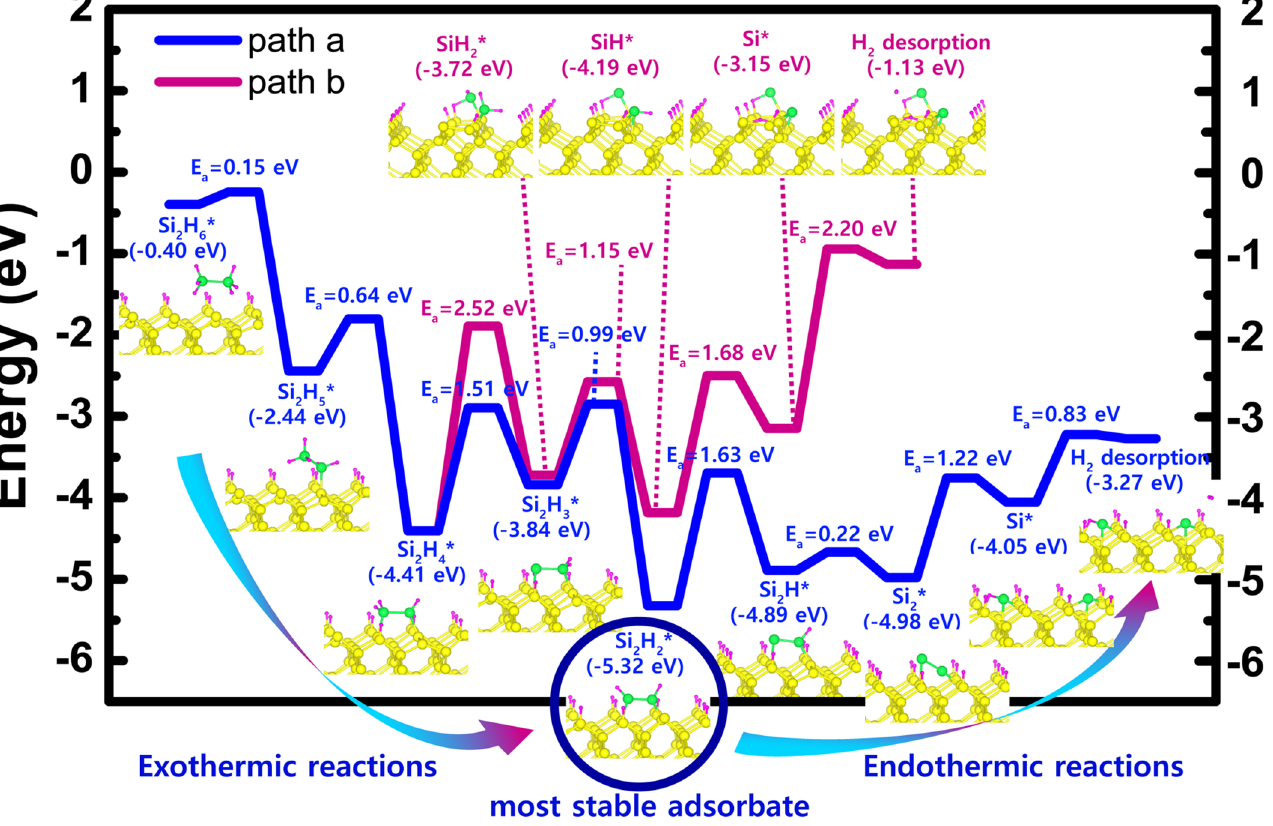
Figure 7. Calculated overall energy diagram of Si 2 H 6 dissociative reactions for path a and b on the H-50% covered Si(001) surface.